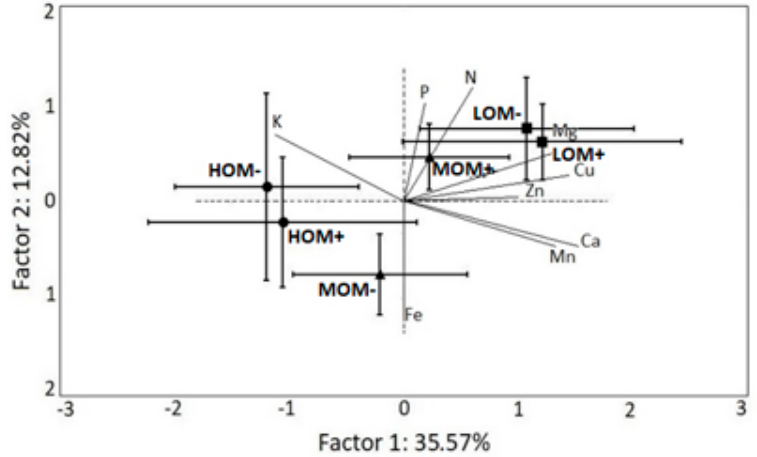
Figure 7. Ordination of the leaf samples according to the leaf nutrient variables on a PCA biplot. Each point corresponds to the mean value of the loadings of the eight samples belonging to the same treatment for the first and the second axis; the first symbol corresponds to the organic matter content (LOM: low, MOM: medium, HOM: high) and the second to the specific irrigation regime (+: irrigation, -: no irrigation). Error bars indicate standard errors for both axes ( n = 8).